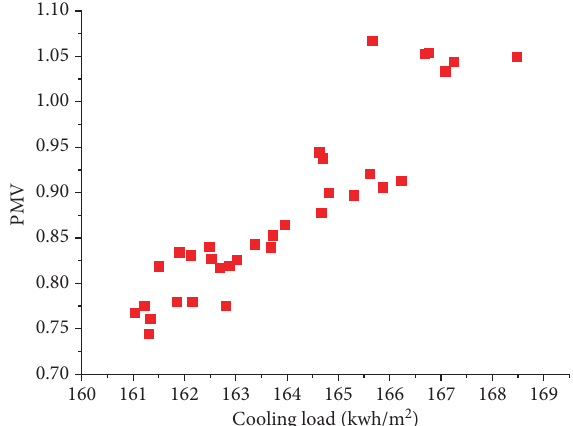
Figure 11: Cooling load and PMV performance of nondominated solutions in the 51st